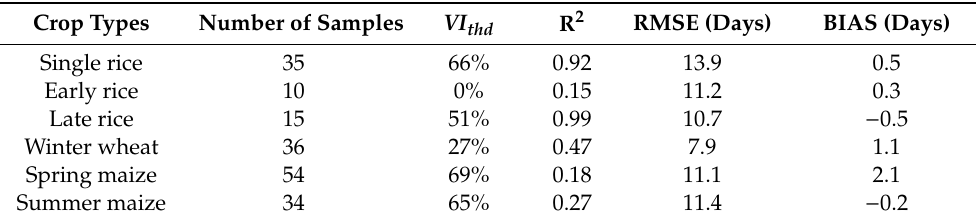
Table 3. The optimal threshold for retrieving the end of the season (EOS) of each crop based on Normalized Di ff erence Vegetation Index